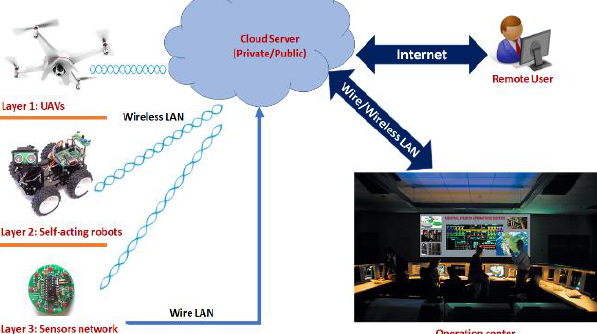
Figure 12. Information transmission diagram in the trade center in the physical